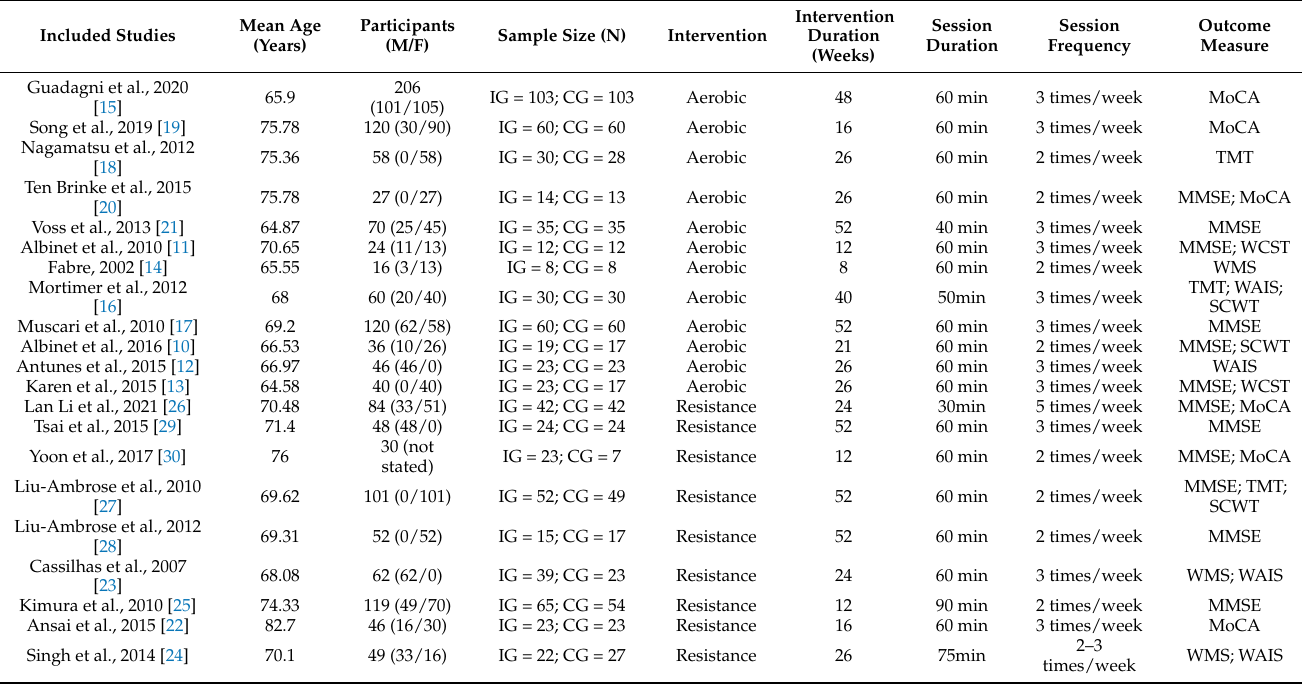
Table 2. Characteristics of the included trials and